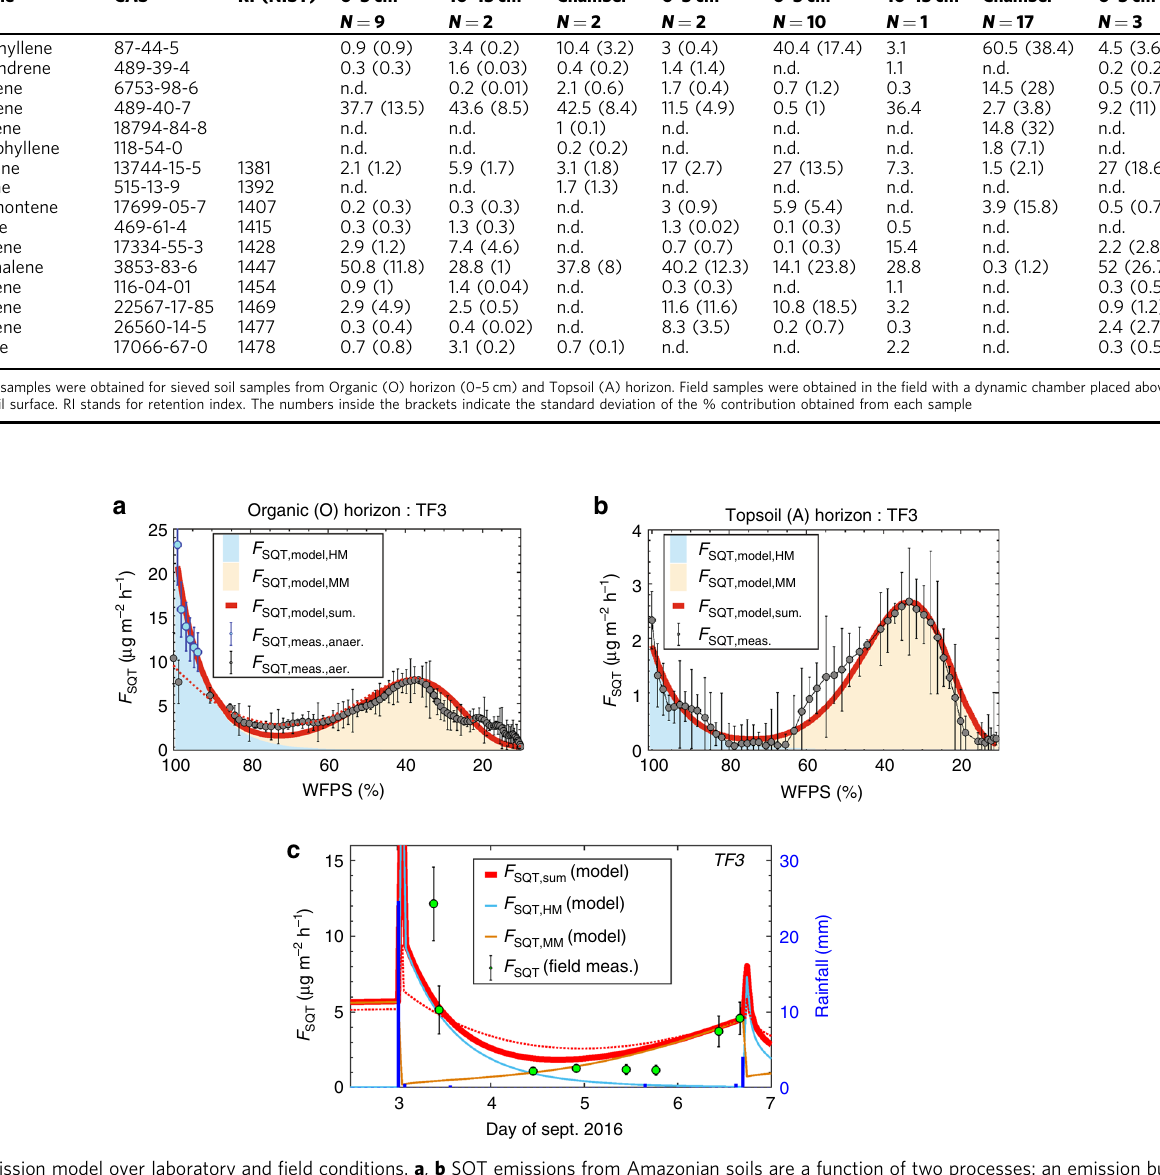
Fig. 5 Emission model over laboratory and fi eld conditions. a , b SQT emissions from Amazonian soils are a function of two processes: an emission burst that occurs after a strong rain event and high moisture (HM; cyan area) and continual microbial emissions that occur at optimum soil moisture conditions over the moderate moisture range (MM; beige area). For the (O) horizon ( a , c ), a rain event may (red line as model output) or may not (red dashed line as model output) activate anaerobic response, so both laboratory experiments (blue points for anaerobic/gray points for aerobic; error bars indicate the standard ( N = 4) of the measurements) were simulated by the model. In c , F SQT,sum was calculated by assuming anaerobic activation down to 90% WFPS and that both (O) and (A) horizons (Fig. 3a, b) contribute to the release of SQT. The green bullets and bars in c indicate the means and standard of the fi eld α -gurjunene, β -caryoplyllene, α -humulene, α / β -cubebene, α - Atmospheric model . Since fi eld measurements of the soil surface fl ux matched closely the SQT sources predicted by our new himachalene, and β -elemene, with their cumulative emission fl ux algorithm, a two-year soil SQT emission fl ux was compiled for a matching the emission pattern and strength of the simulated seasonal comparison with SQT emissions from the treetop emissions. In addition to TF3, fi eld measurements were con- canopy, as simulated by a widely used code (MEGAN v2.04) ducted at the strong emitter soil TF1. Similar to TF3, the emission within a global model (EMAC) (Fig. 6). The modeled data from strength was predicted reasonably well by our model algorithm both soil and canopy encompassed two wet seasons (model prediction: 114 μ g m − 2 h − 1 , fi eld measurements 100 ± 56 μ g m − 2 h − 1 ). (February – June) and two dry seasons (July – December) the last of